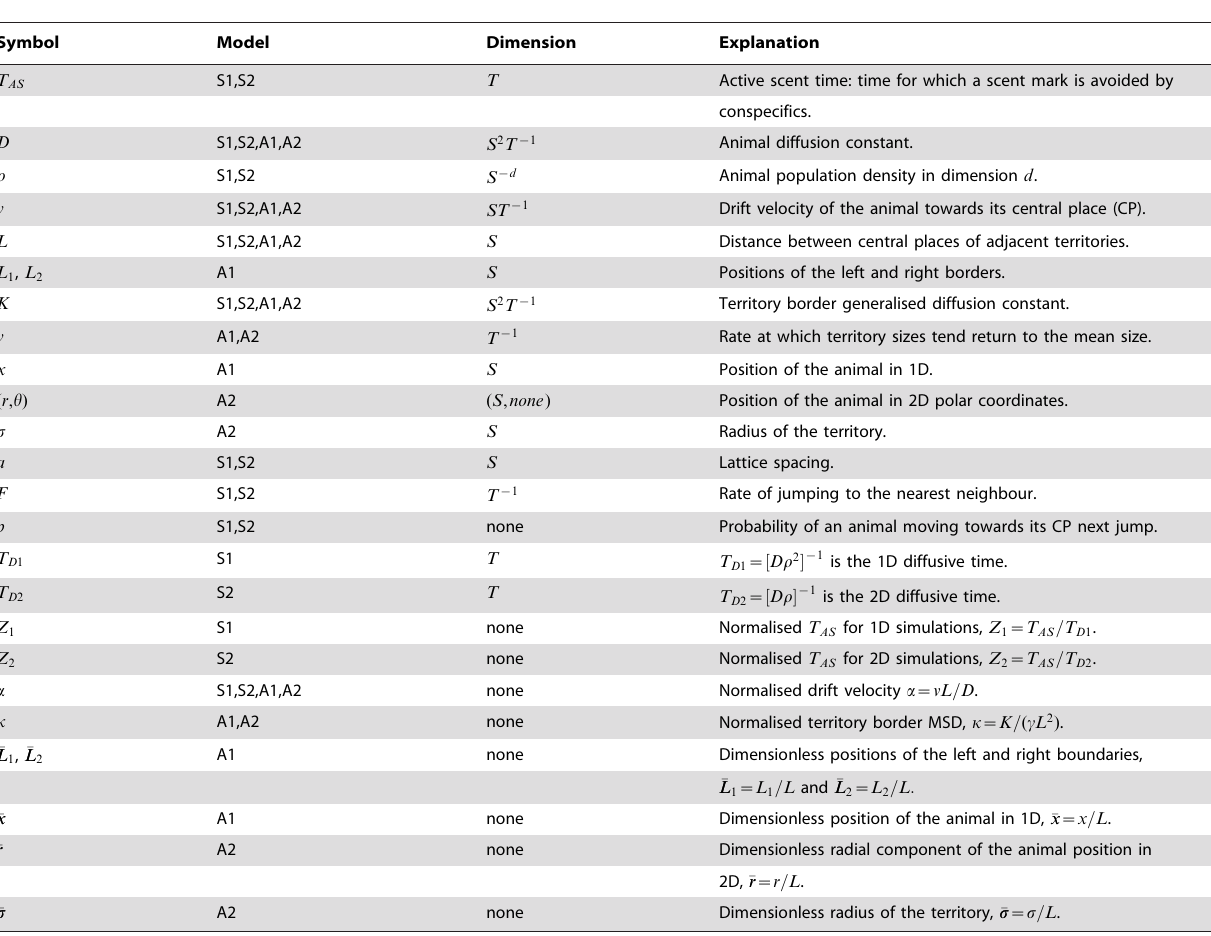
Table 1. Notation glossary.